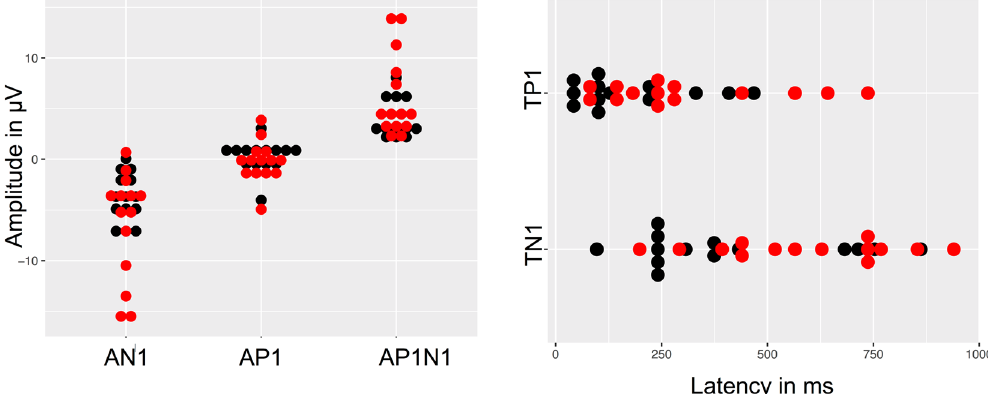
Figure 2. Electrophysiological responses at the olfactory epithelium in response to the odour enantiomers of ( − )- rose oxide and ( + )- rose oxide. The black and the red dots show responses to R ( − ) and R ( + ) respectively. ( A ) Mean EOG amplitudes (base-to-peak) AN1 and (peak-to-peak) AP1N1 of ( − )- and ( + )-rose oxide differ significantly ( * p < 0.05), with higher amplitudes in response to ( + )-rose oxide. ( B ) EOG peak latencies TP1 and TN1 of each participant in response to ( − )- and ( + )-rose oxide. Significantly higher mean latencies TP1 and TN1 were obtained after ( + )-rose oxide odour stimulation ( * p < 0.05).